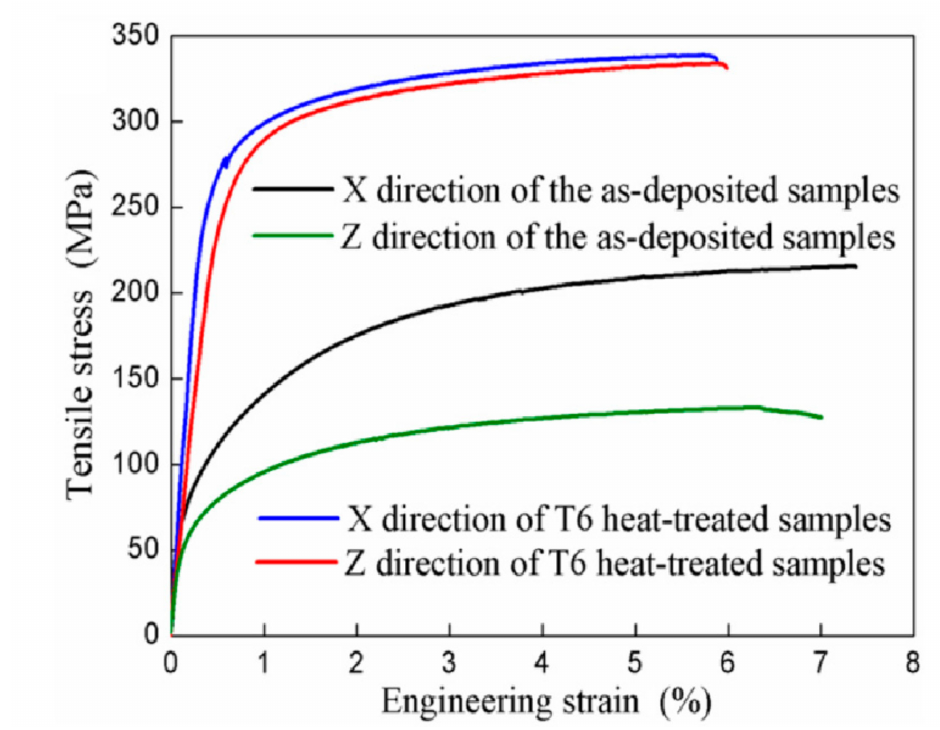
Figure 8. Tensile test of TiB 2 /AlSi7Mg0.6 composites. Table 2. Mechanical properties of TiB 2 /AlSi7Mg0.6 composites fore-and-aft T6 heat